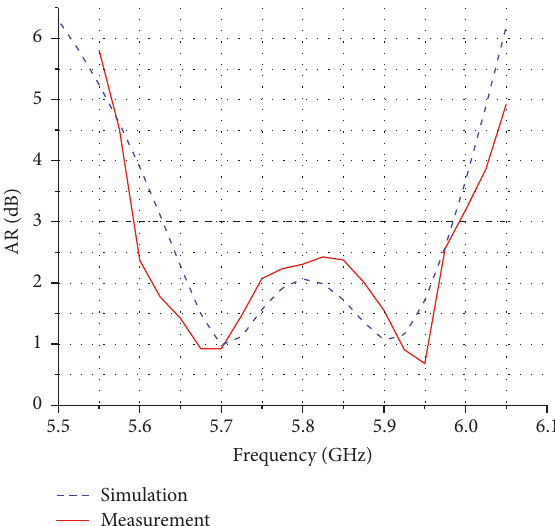
Figure 11: Measured and simulated AR of the 1 × 2 linear array.